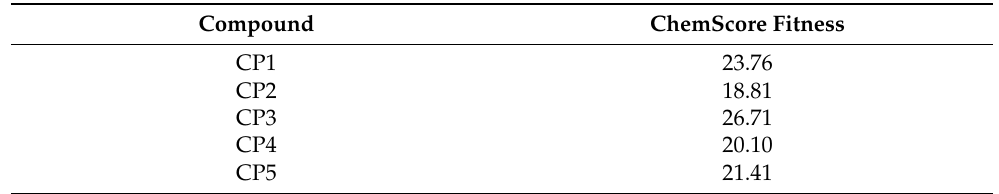
Table 3. Docking score of the components of the essential oil of chamomile expressed as Chem- Score